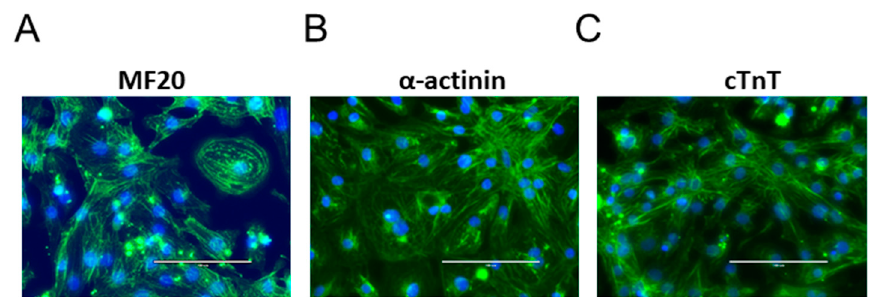
Figure 1. 40X images of iPS-CMs stained for the cardiac markers α -actinin, myosin, and cardiac troponin T. ( A ) myosin, ( B ) α -actinin, and ( C ) cTnT are all positive.